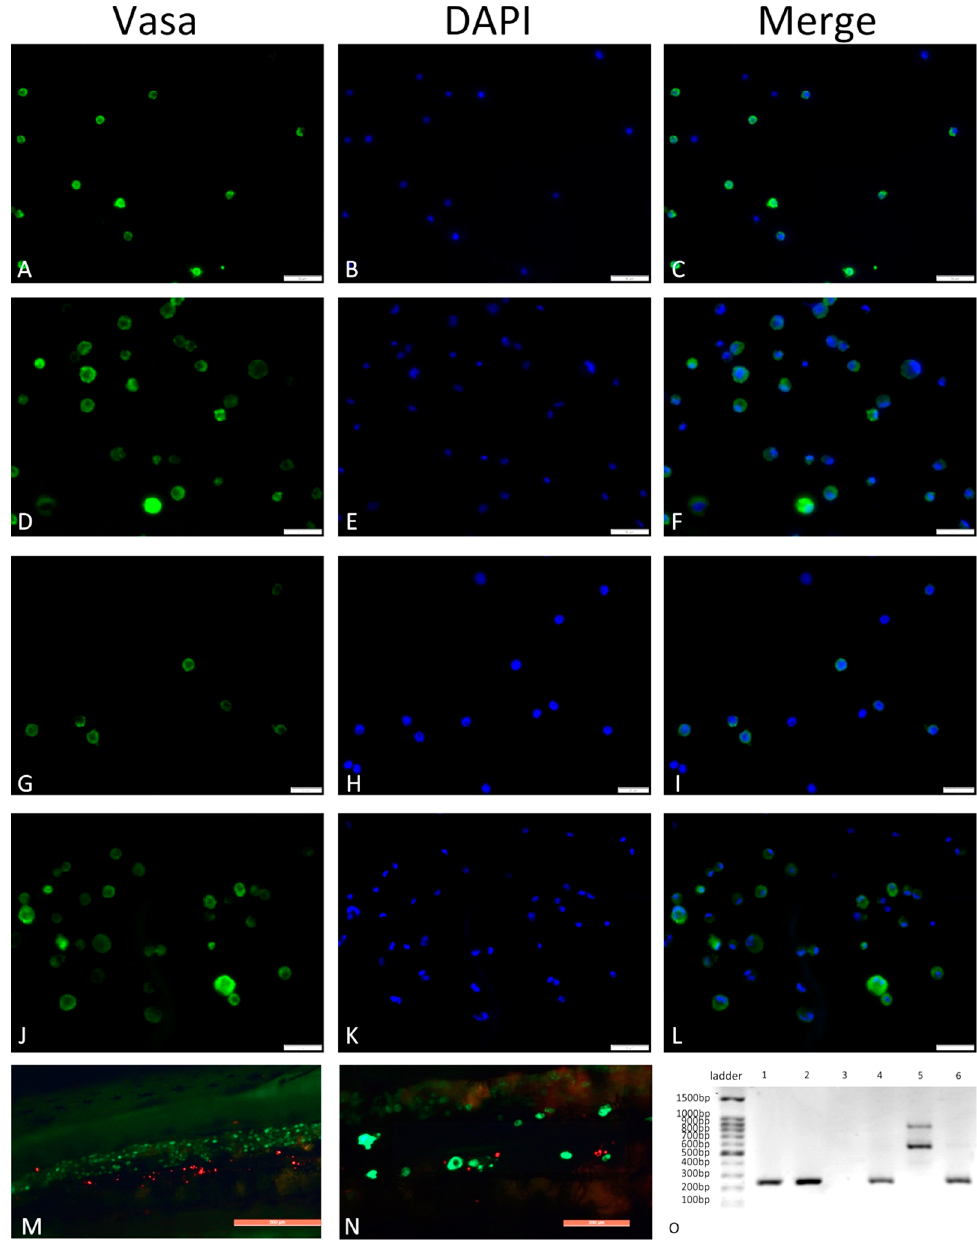
Figure 8. Immunofluorescence of sterlet germ cells in serum-free medium. Purified spermatogonia